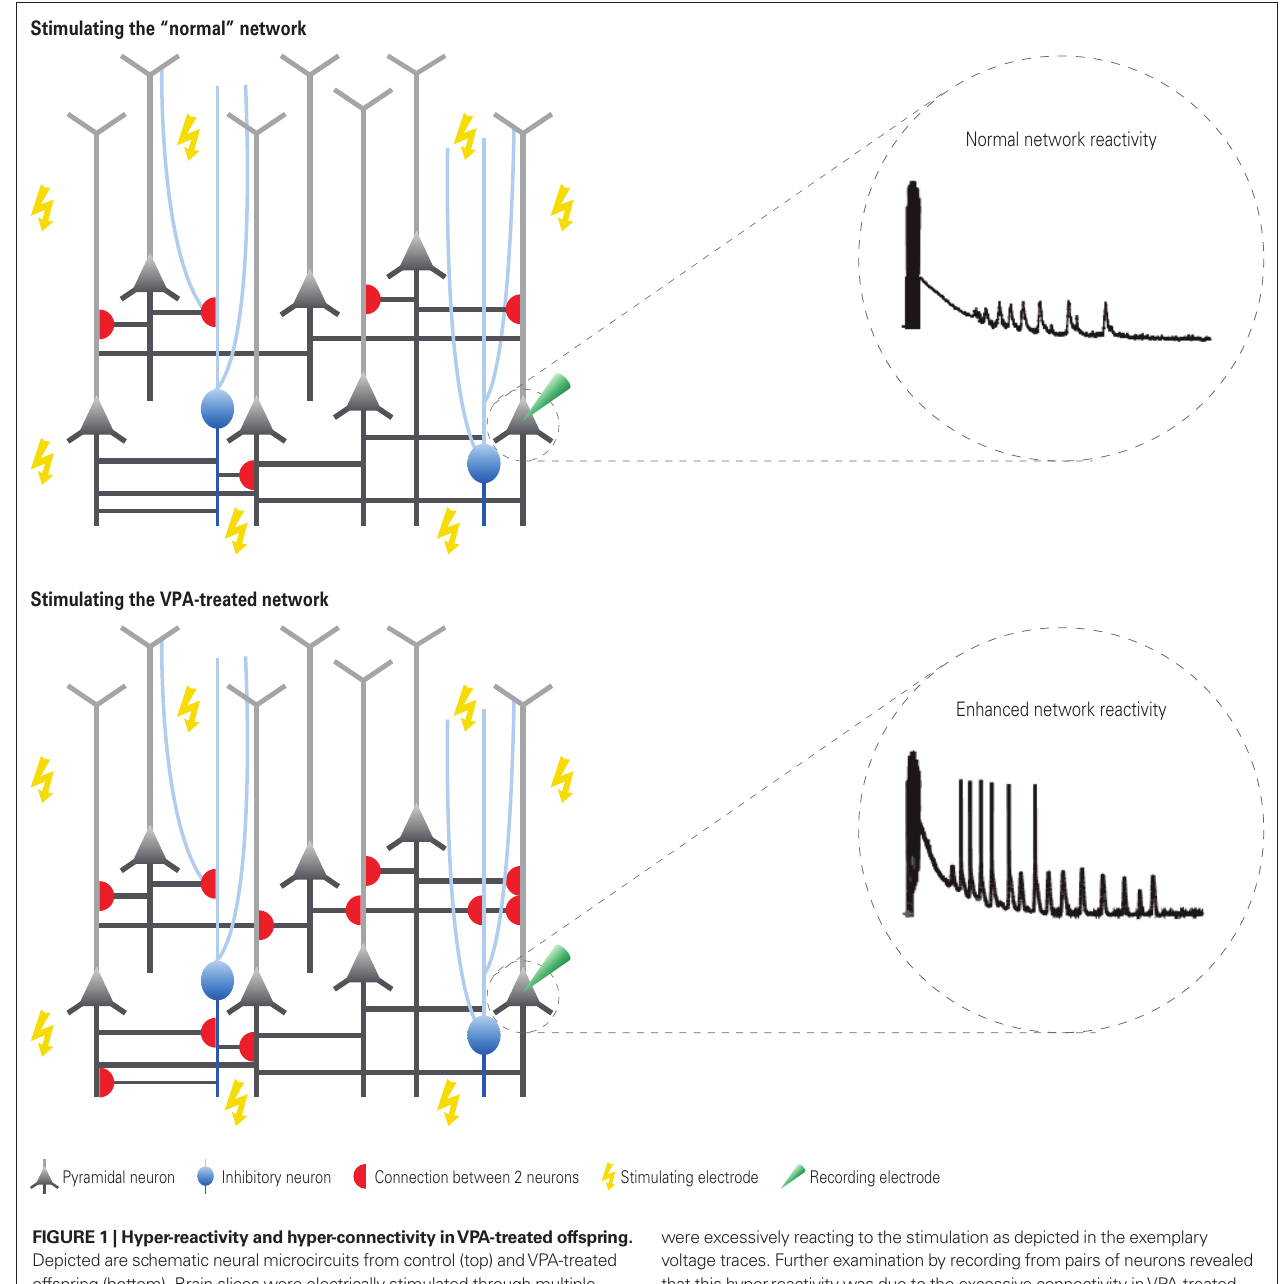
Figure 1 | Hyper-reactivity and hyper-connectivity in VPA-treated offspring. Depicted are schematic neural microcircuits from control (top) and VPA-treated offspring (bottom). Brain slices were electrically stimulated through multiple stimulation electrodes underneath the slice – a multi-electrode array. The responsiveness to this network stimulation was recorded from individually patched cells. In comparison to controls, neurons from VPA-treated offspring